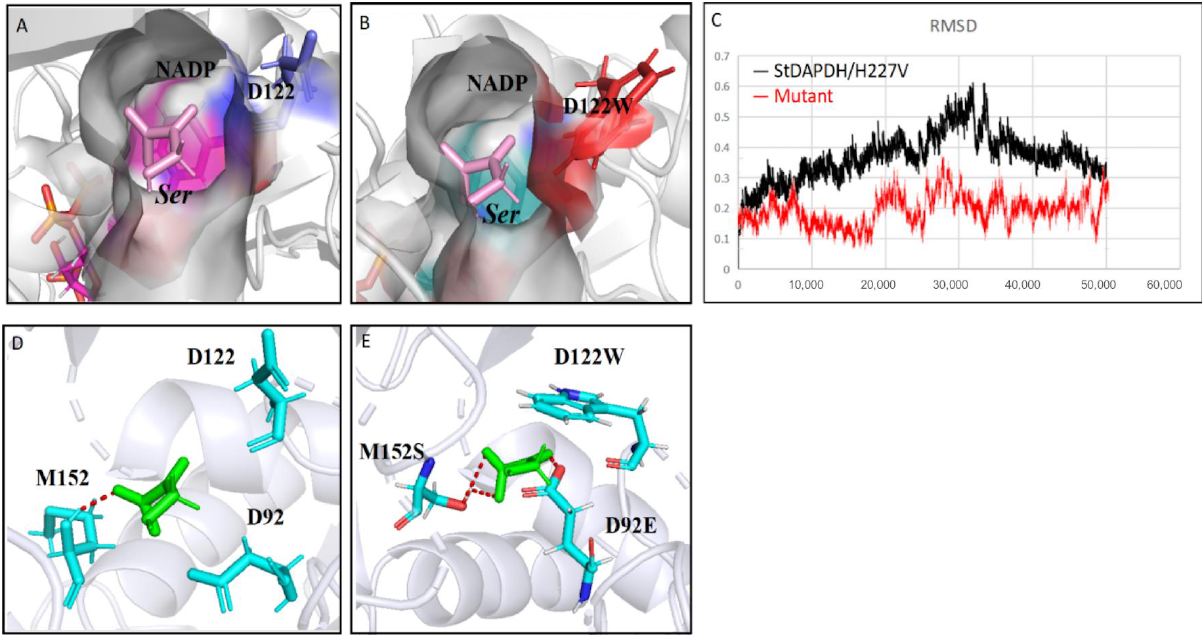
Figure 6. Structural analysis of the mutation sites. ( A ) The docking structure of the pocket of StDAPDH/H227V with HPPA; ( B ) the docking structure of the pocket of M3 mutant with HPPA; ( C ) root-mean-square displacement of StDAPDH/H227V and M3 mutant; and ( D ) interaction be- tween hydroxypyruvate (HPPA) and key sites of StDAPDH/H227V. Red: hydrogen bond; blue: key site; and green: HPPA. ( E ) Interaction between HPPA and key sites of M3 mutant. Red: hydrogen bond; blue: key site red as the substrate.